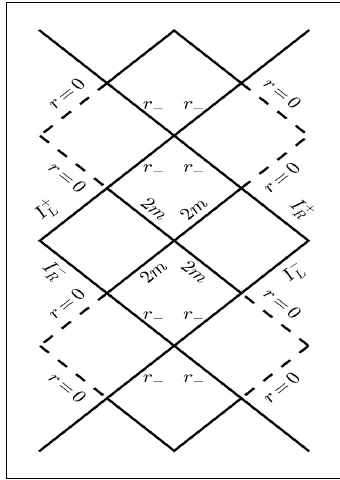
Figure 1. Carter-Penrose diagram for a self-dual black hole. The LQBH scenario possess two asymptotic regions, one at infinity and the other near the origin, which no observer can reach in a finite